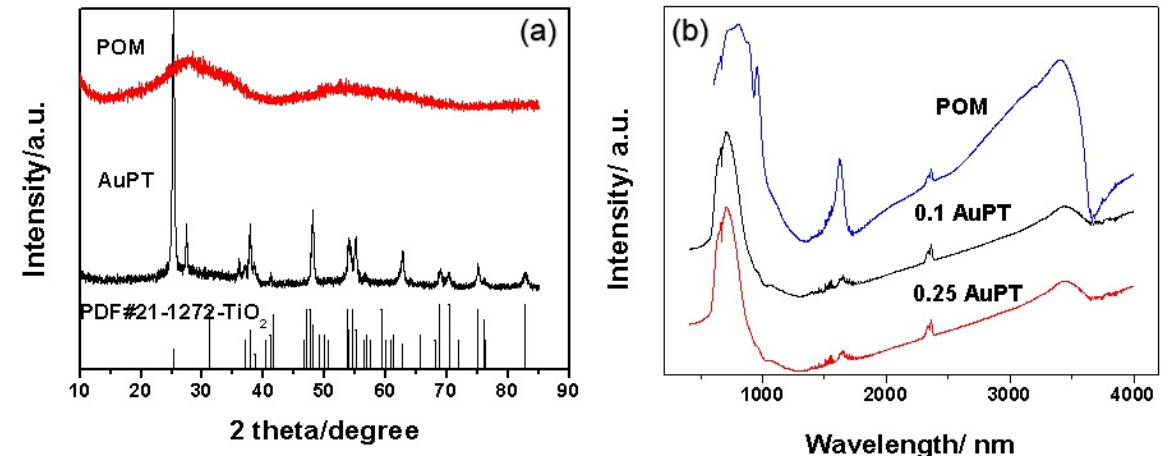
Figure 1. ( a ) The XRD patterns and ( b ) infrared spectra of the i AuPT and POM catalysts, and the standard cards for anatase (No. 21-1272) and rutile (No. 21-1276).